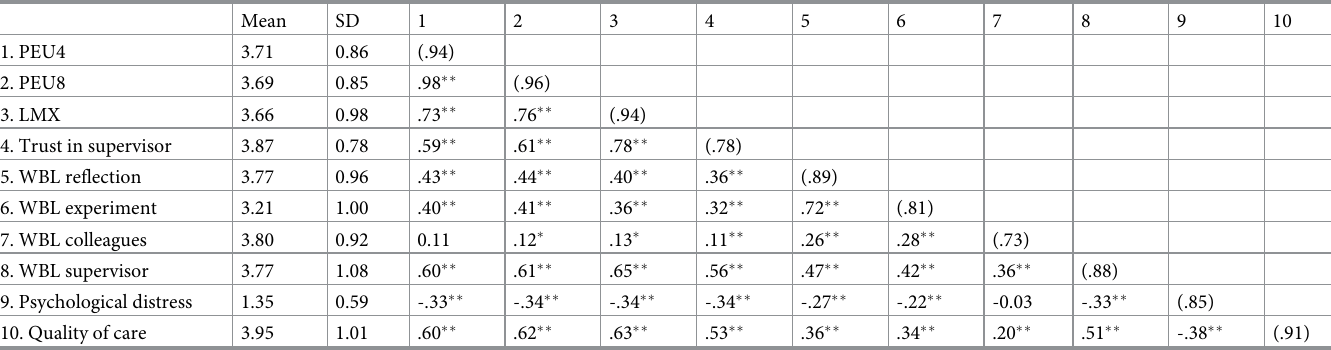
Table 8. Descriptive statistics, correlations, reliabilities for hypothesized model (Study 5).